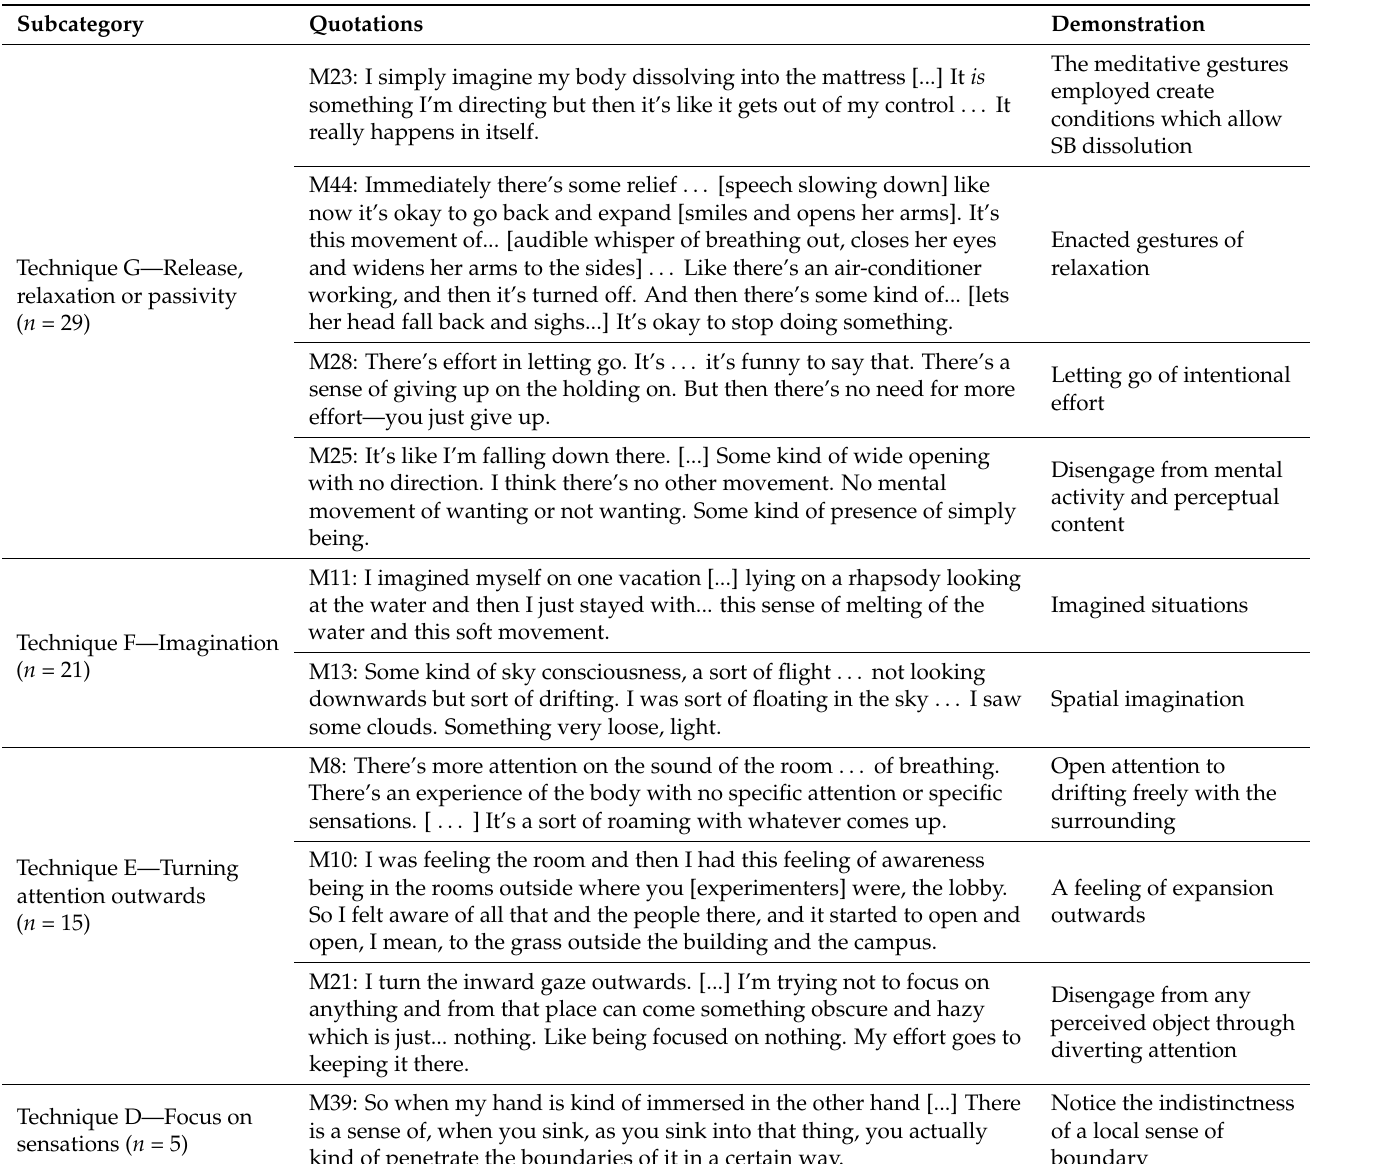
Table 5. SB − representative examples of meditation technique.